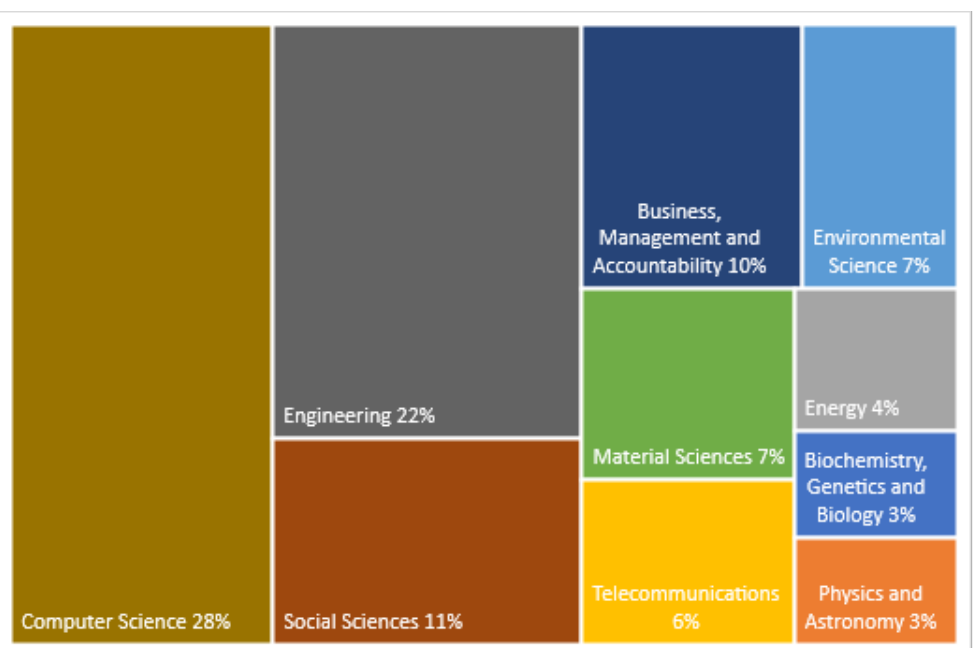
Figure 3. Knowledge areas with the highest number of publications in both databases.